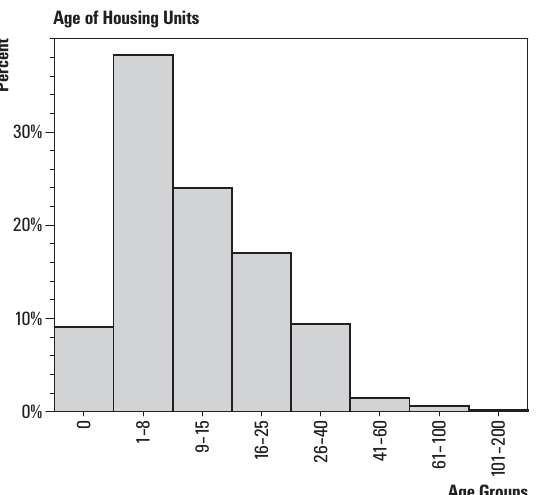
Figure 4. Number of rooms in the housing